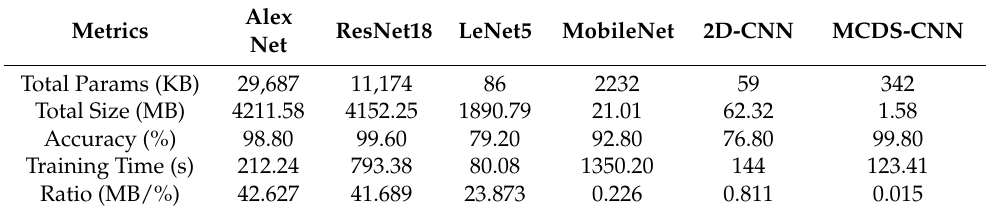
Table 6. Ratio and other performances of the proposed model, MCDS-CNN, and other five models on data set A.